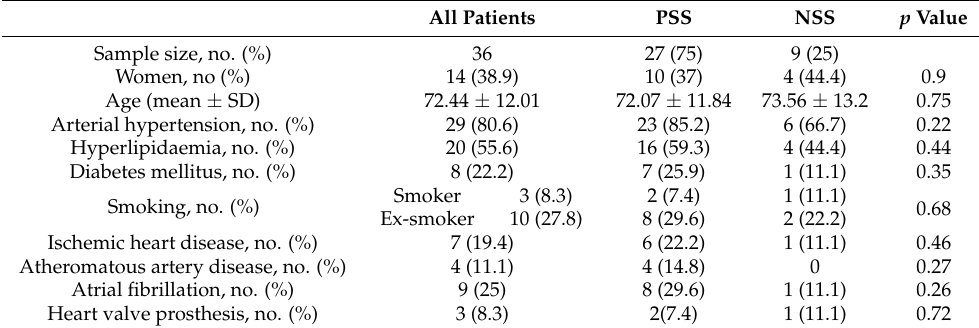
Table 1. Demographic characteristics and vascular risk factors.